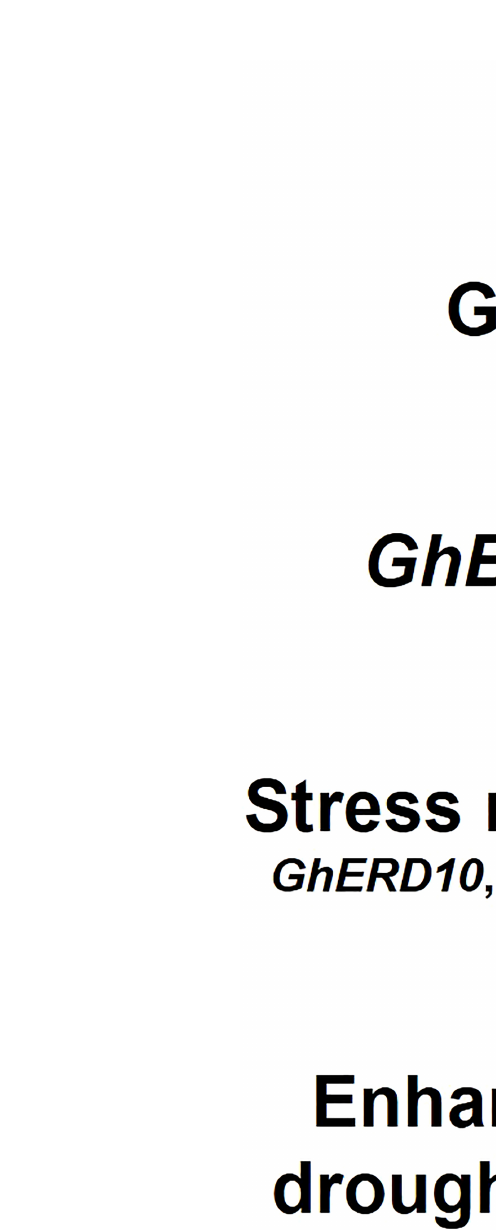
FIGURE 9 Hypothetical model of BR-regulated drought tolerance in cotton via GhBEE3-Like . BRs active GhBZR1, a key TF of BR signaling pathway, to repress the expression of GhBEE3-Like . In turn, the down-regulation of GhBEE3-Like leads to the high expression of stress-related marker genes that enhance cotton drought